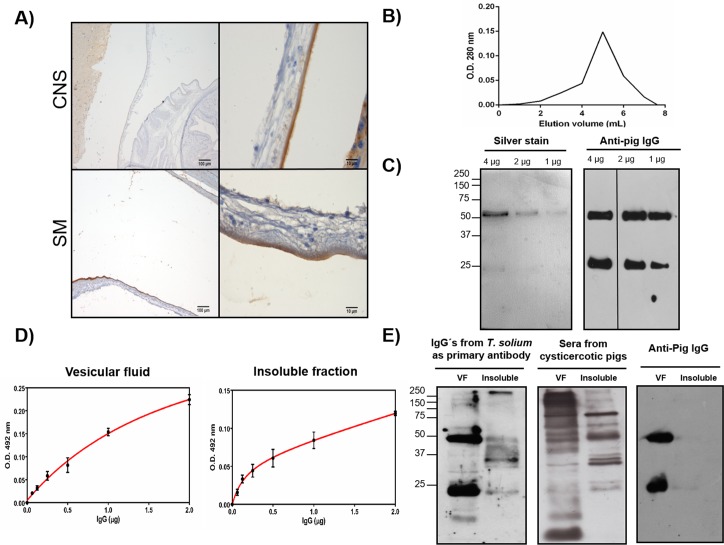
Immuno-localization and functional evaluation of host immunoglobulins purified from protein extracts of Taenia solium cysts.A) Immuno-localization of host IgG in cysts obtained from the central nervous system and skeletal muscle of pigs. B) Immunoglobulins present in total protein extracts of cysts were purified using a Sepharose 4B column coupled with Protein G. C). The purity of the bound IgG was evaluated by SDS-PAGE and western blotting using an anti-pig IgG coupled to HRP. D) The antibody activity of purified IgG was evaluated by ELISA. Samples of T. solium vesicular fluid and insoluble fraction were used to coat 96 well microtiter plates. Afterwards, the purified IgG was incubated overnight at 4°C under slow agitation. Then, the antigen-antibody reaction was developed using a colorimetric method. E) Recognition of cysts proteins by the purified IgG through western blotting. Samples of T. solium vesicular fluid and insoluble fraction were resolved through SDS-PAGE and then transferred onto a nitrocellulose membrane. The purified IgG from cysts protein extracts was used as primary antibody (for comparison sera from cysticercotic pigs was also included) and an anti-pig IgG coupled to HRP was used as secondary antibody. Lower right panel shows the reaction with the secondary antibody alone as control.